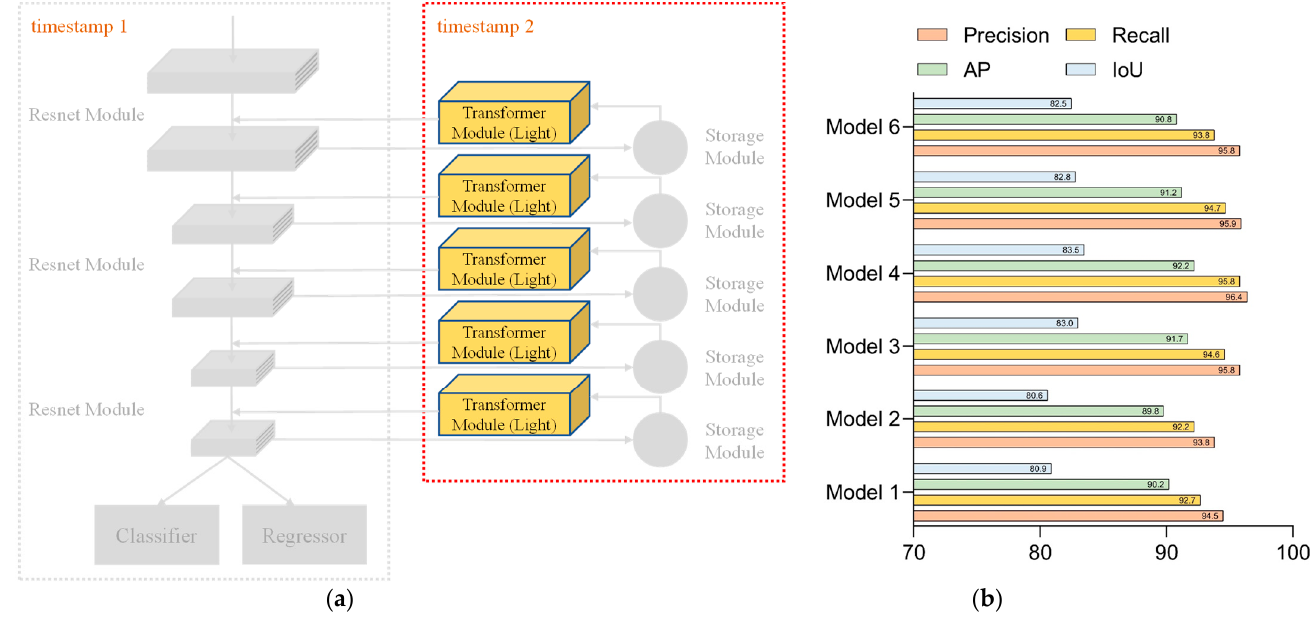
Figure 11. Network 4: ( a ) configuration of Network 4 and ( b ) test results for each parameter of Network 4.